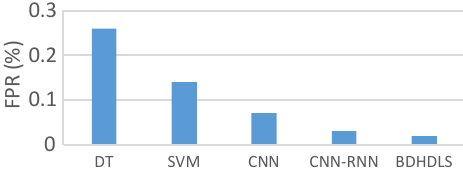
Fig. 7 FPR for different feature sets in the ISCX2012 dataset.